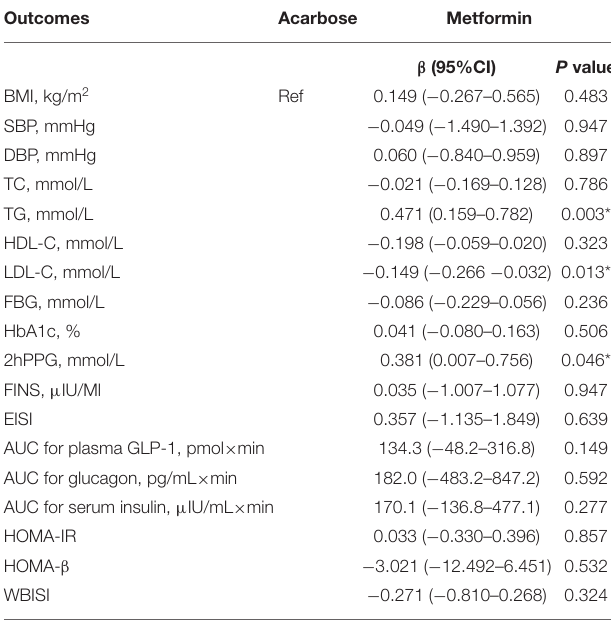
TABLE 2 | Independent effects of drug treatment on clinical outcomes in linear mixed-effect